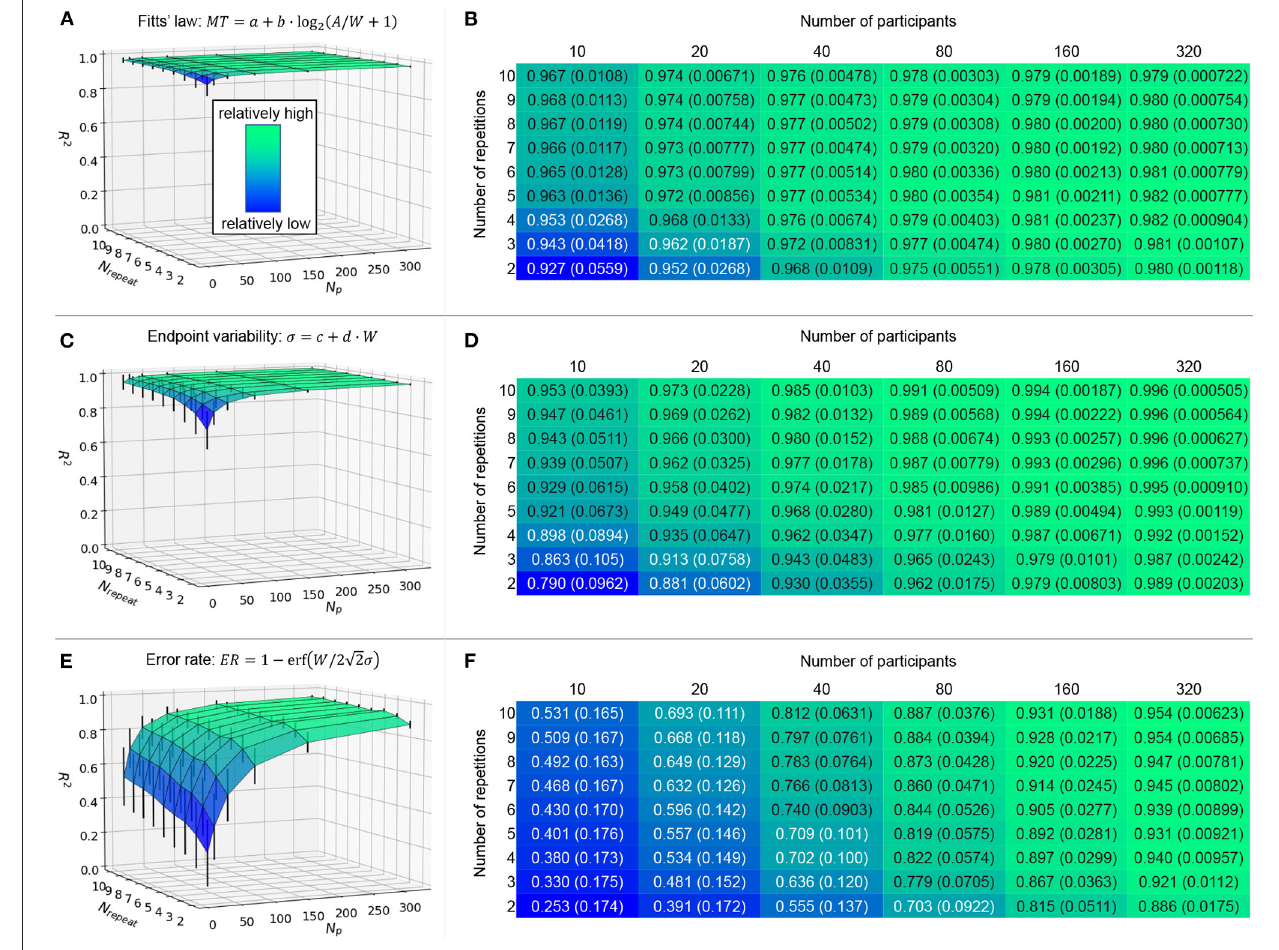
measure the central tendency of error rates. This benefit